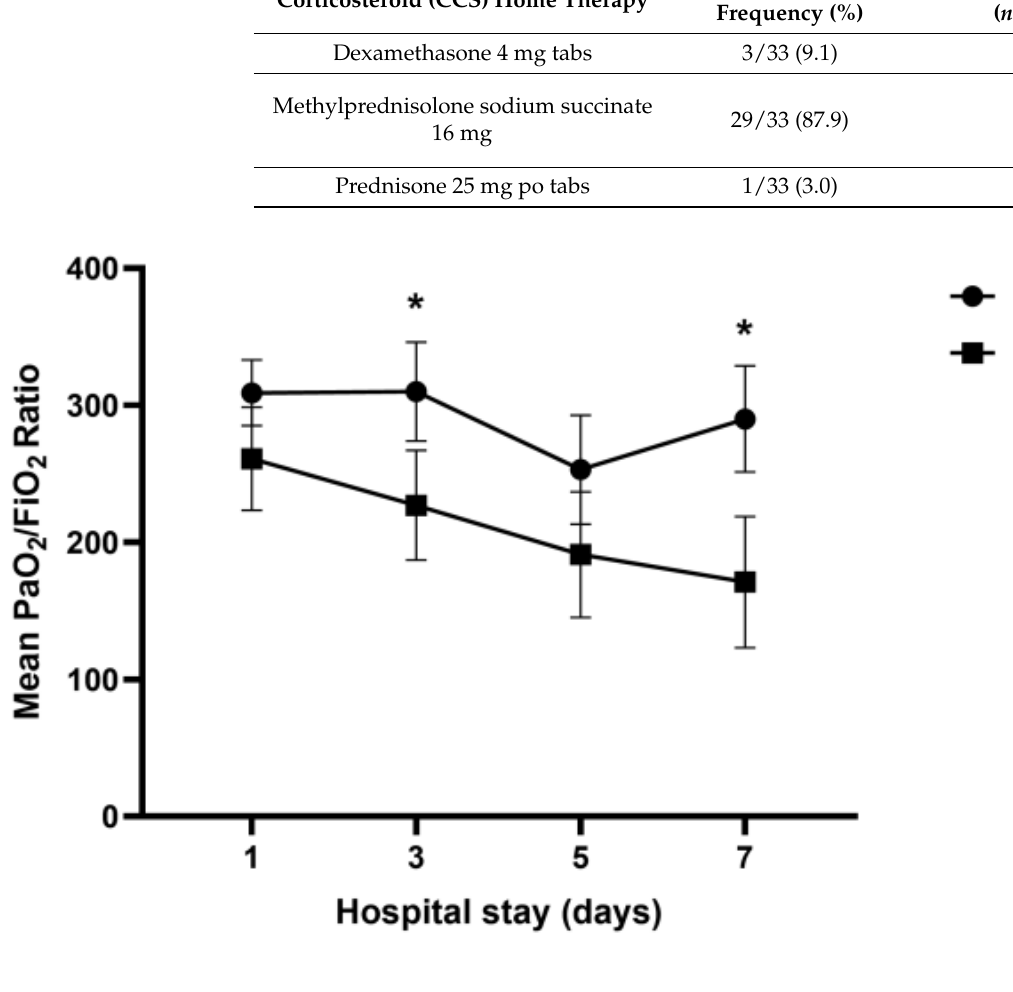
Figure 1. Trends of median PaO 2 /FiO 2 ratio from hospital admission to Day 7. * p < 0.05.